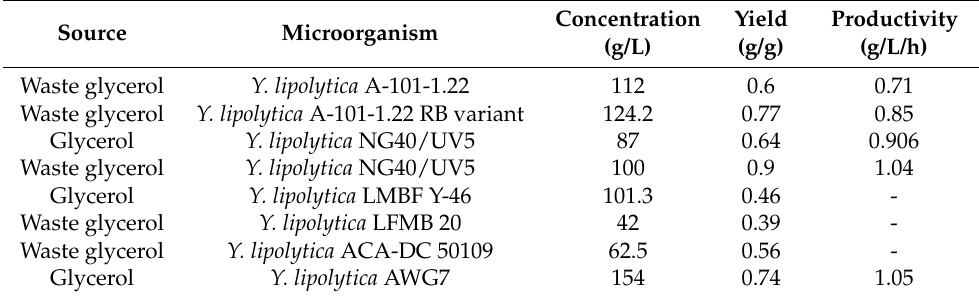
Table 3. Biological conversion of glycerol into citric acid (CA) by Yarrowia lipolytica . Source Microorganism